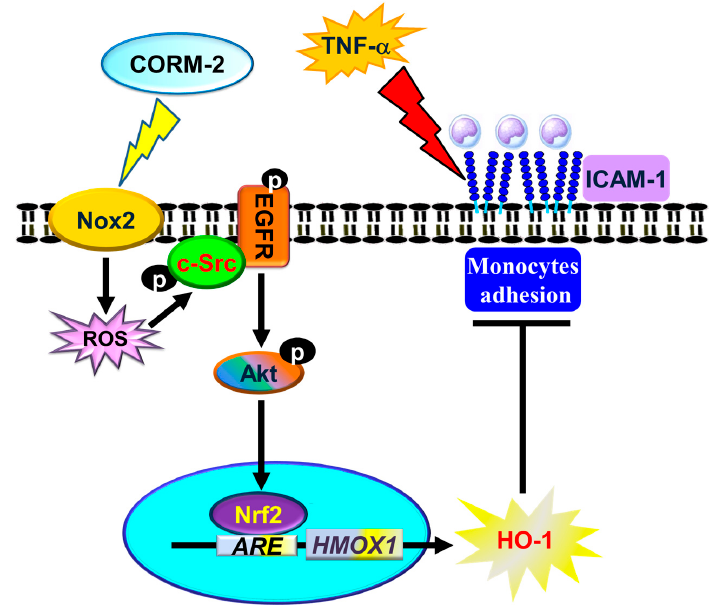
Figure 8. A model for the molecular mechanisms underlying CORM-2-induced HO-1 expression and activity in HPAEpiCs. CORM-2-induced HO-1 expression was mediated through Nox/ROS and c-Src/EGFR-dependent activation of PI3K/Akt, linking to the upregulation of Nrf2/AREs, which promoted HO-1 expression and enzymatic activity in HPAEpiCs. Upregulation of HO-1 suppressed the inflammatory responses triggered by TNF- α in both in vitro and in vivo studies. ROS act as a messenger in normal physiological functions, and inflammatory responses are dependent on their cellular concentrations [44,45]. It has been reported that the upregulation of HO-